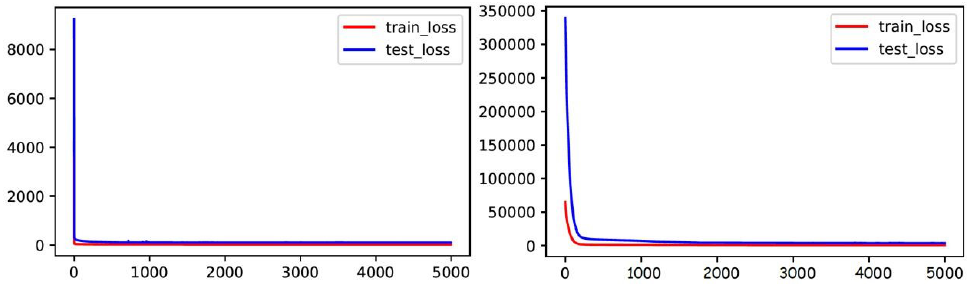
Figure 4. Train and test loss graph for the 15 minutes prediction for the SZ-taxi ( right ) and Los-loop ( left )